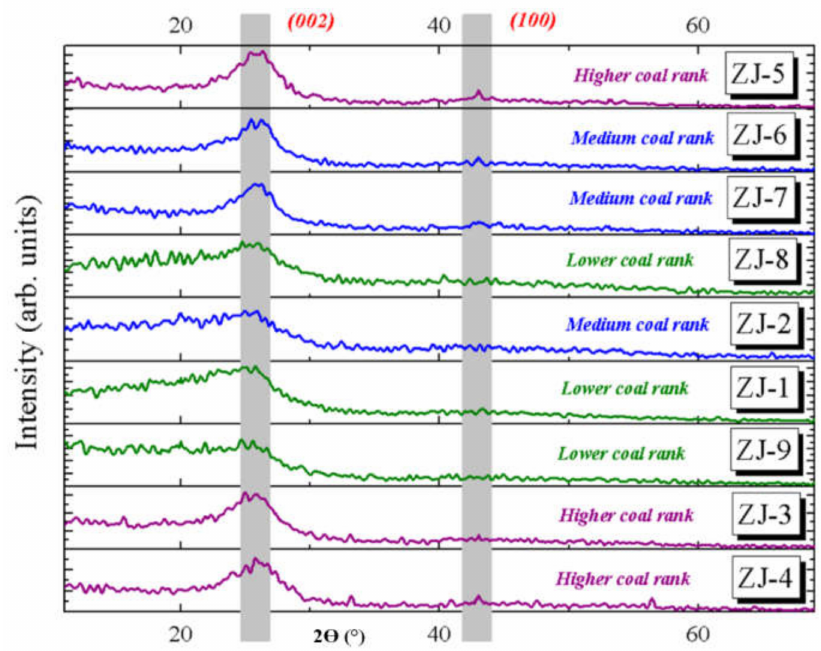
Figure 8. Wavelength dispersive X-ray diffraction profiles for demineralized coal samples